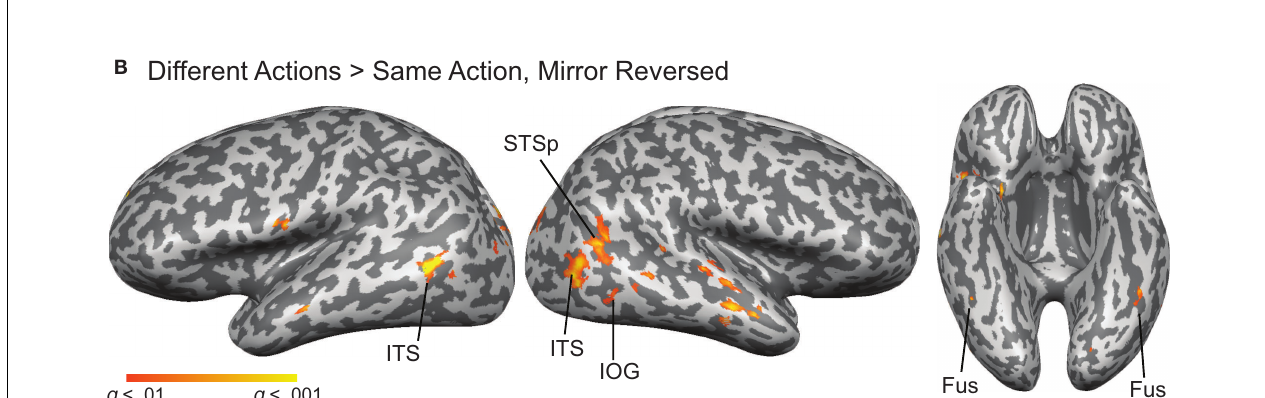
(Different actions – Repeated actions). (B) Group contrast testing for adaptation in trials depicting the same action from two viewpoints (Different – Mirror Reversed). All contrasts are thresholded at a false discovery rate of q <